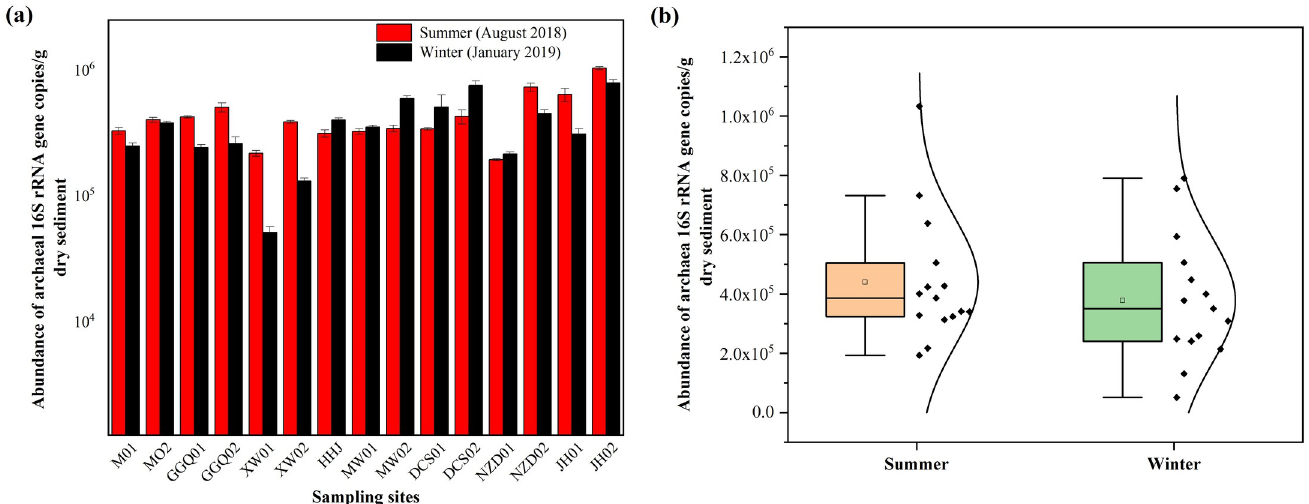
Fig 2. The abundance of archaeal 16S rRNA gene in summer and winter sediments of LRCR.